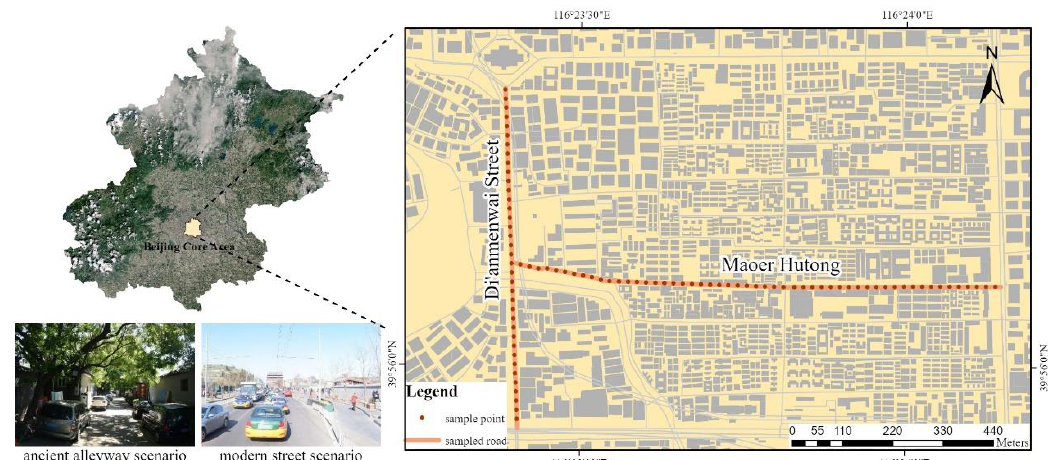
Figure 1. Study area.